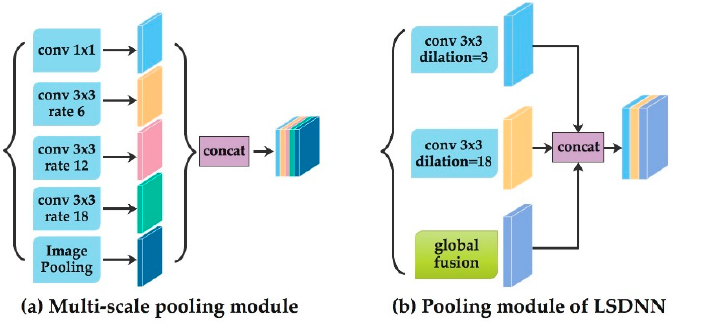
Figure 5. Pooling part. ( a ) Multiscale pooling module; ( b ) pooling module of laser-stripe-detection neural network (LSDNN) that has two dilated convolution layers and one global fusion module.